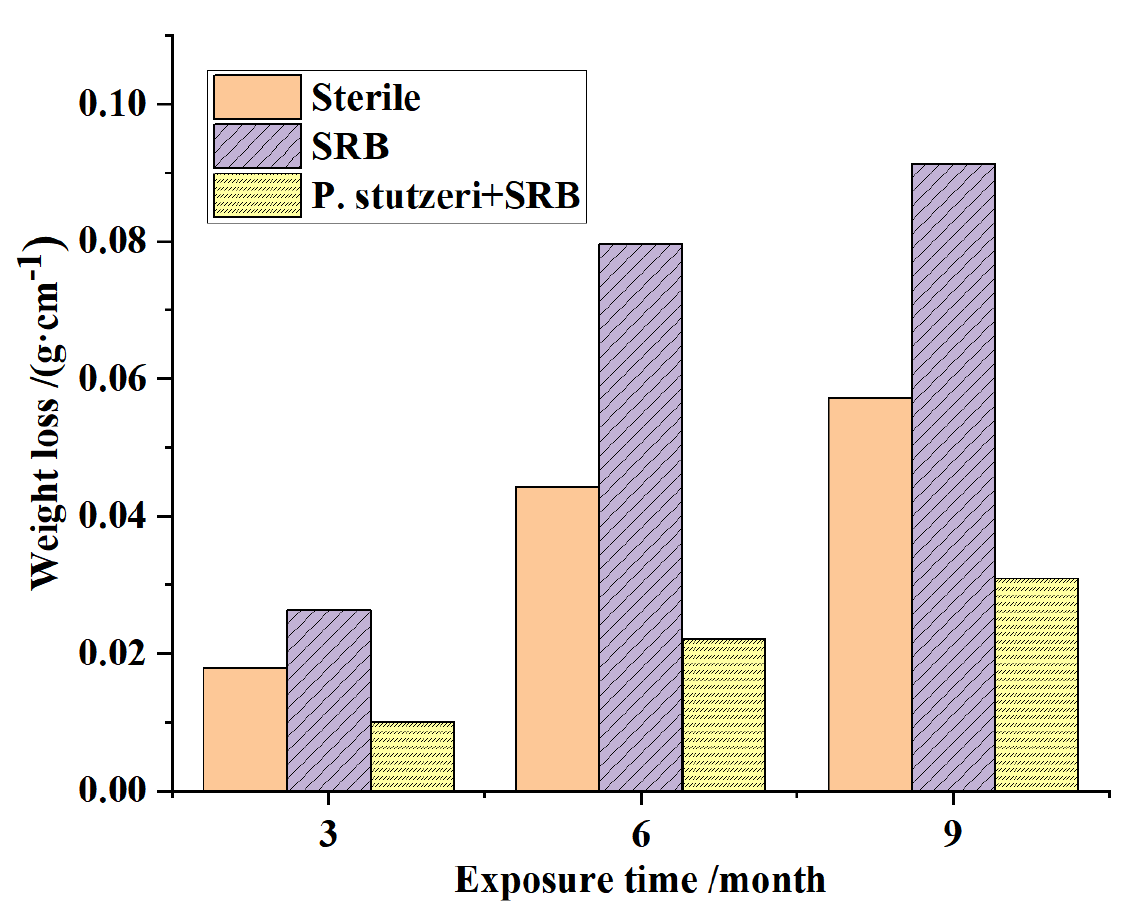
Figure 11. Weight losses of steel coupons from long-term exposure (3, 6, 9 months) .